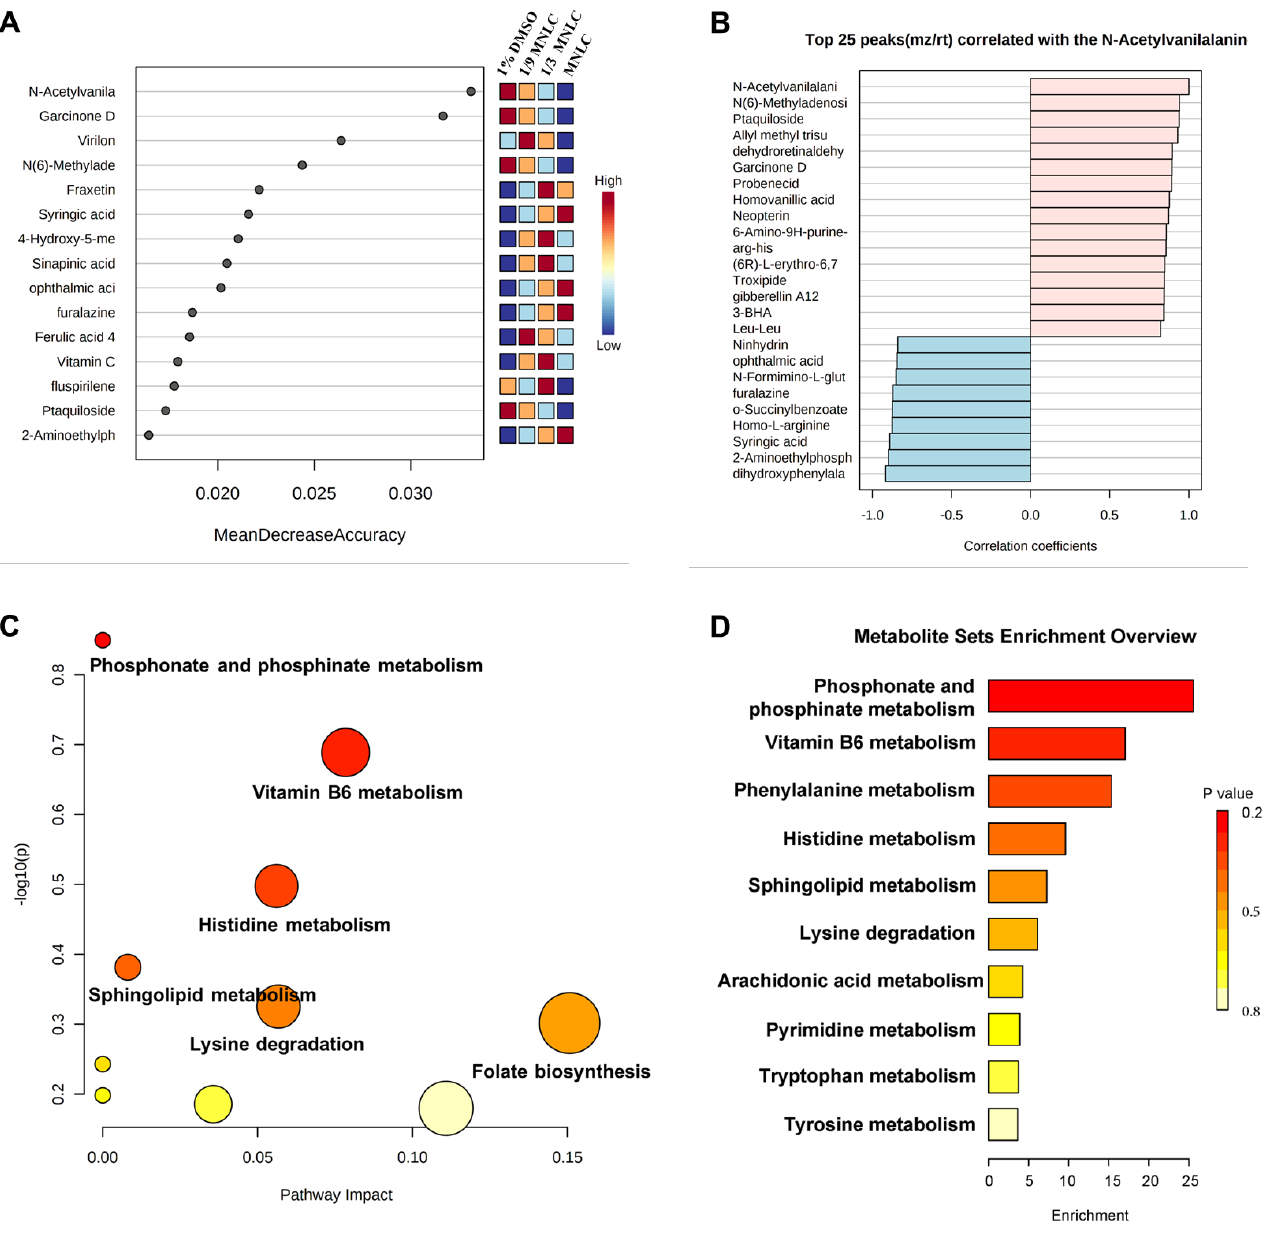
Figure 5. ( A ) Random forest of differential metabolites; Features ranked by their contributions to classification accuracy (Mean Decrease Accuracy). ( B ) Top 25 peaks correlated with the N-Acetylvanilalanine. ( C , D ) Pathway analyses with MetaboAnalyst 5.0 for the metabolic profiles of zebrafish embryos treated with scopoletin.